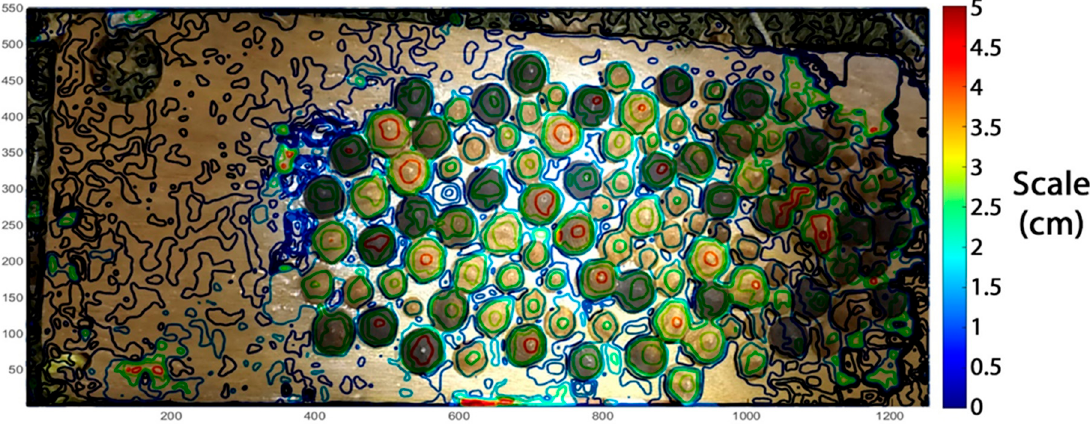
Figure 11. Reconstructed image from left and right pictures corresponding to the conditions of Figure 3.